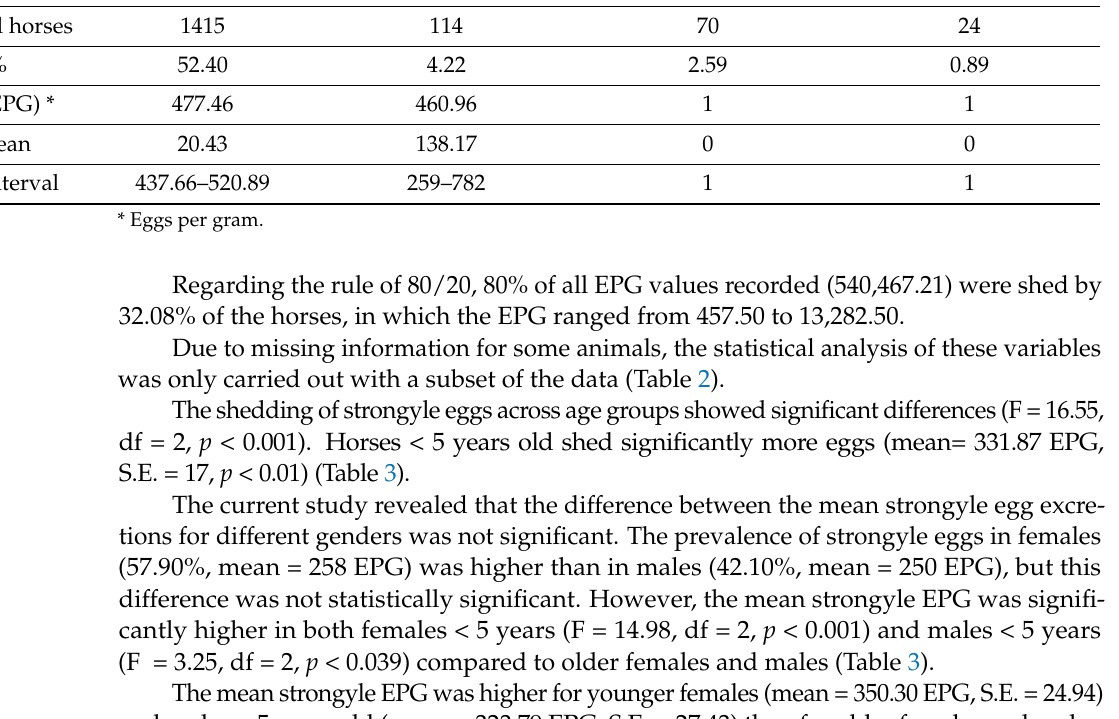
Table 1. Prevalence of infection with different helminth parasites in 2700 horses from Irish farms extrapolated from faecal egg counts. Horses Infected with Various Helminth Parasites Strongyle Parascaris spp. Anoplocephala spp. Strongyloides westeri 1415 114